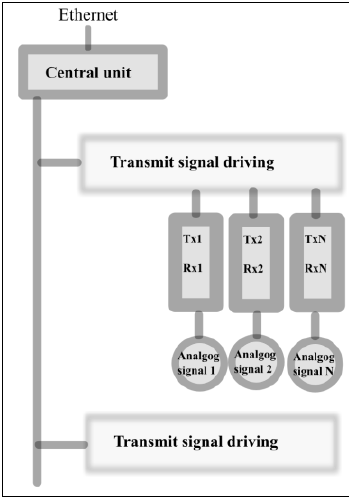
Fig. 8. Schema of the microelectronics.